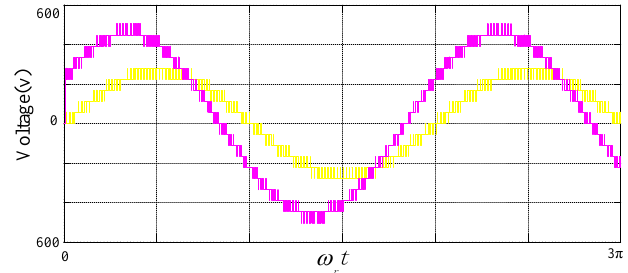
Figure 12. Phase and line voltage under the discontinuous modulation.